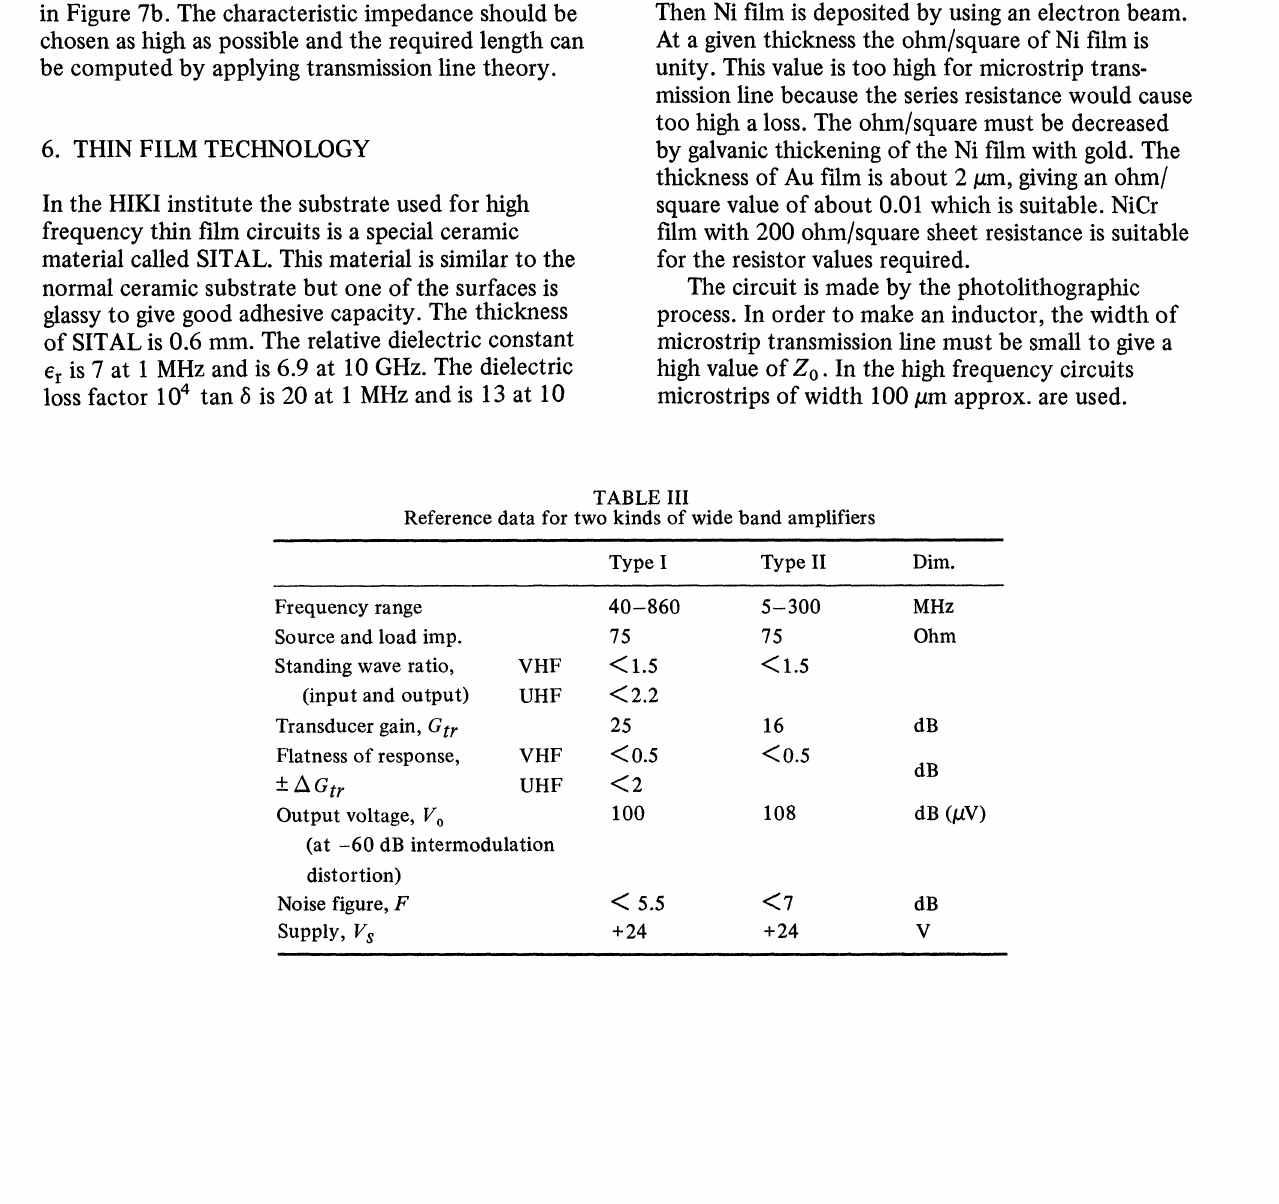
FIGURE 7 Characteristic impedance of a microstrip (a) and the rate of shortening of wavelength in a microstrip (b) as functions of w/h. Xo wavelength in vacuum, Xm wavelength in microstrip.